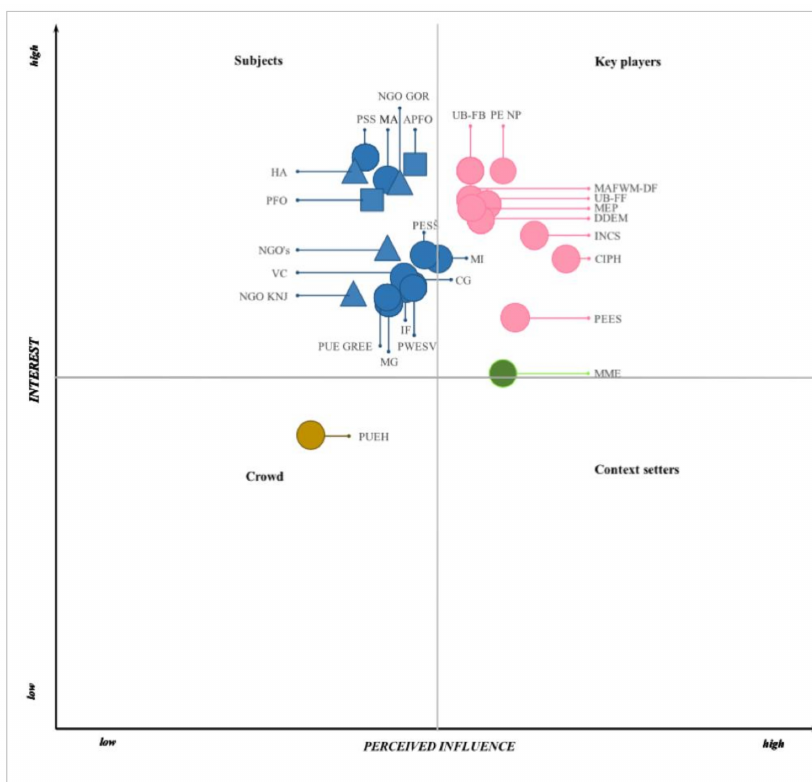
Figure 2. Matrix of stakeholders’ interest and perceived influence in climate change governance. Color of the circle reflect position in the quadrant (subjects—blue color; key players—pink color; context setters—green color; crowd—brown color). The shape of the symbol reflects the sector affiliation (circle—public sector; triangle—civil sector; square—private sector).